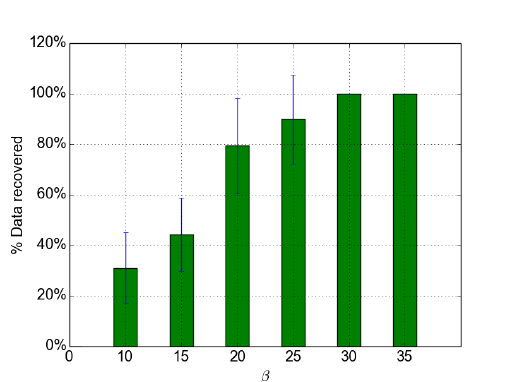
Figure 15. Percentage of data packets recovered.